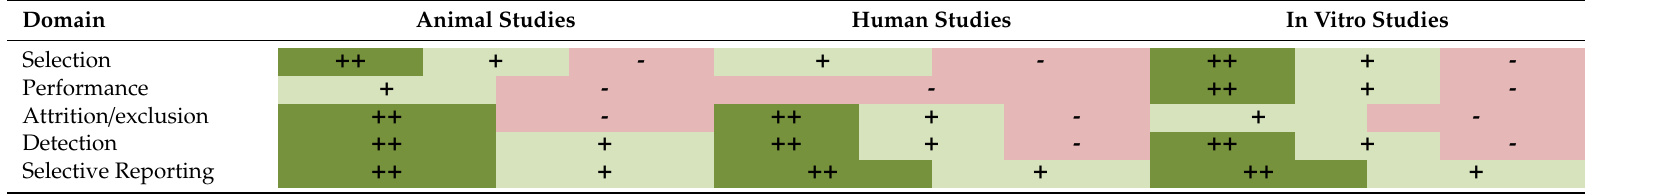
Table A3. Summary risk of bias domain assessment for animal, human and in vitro studies included in the